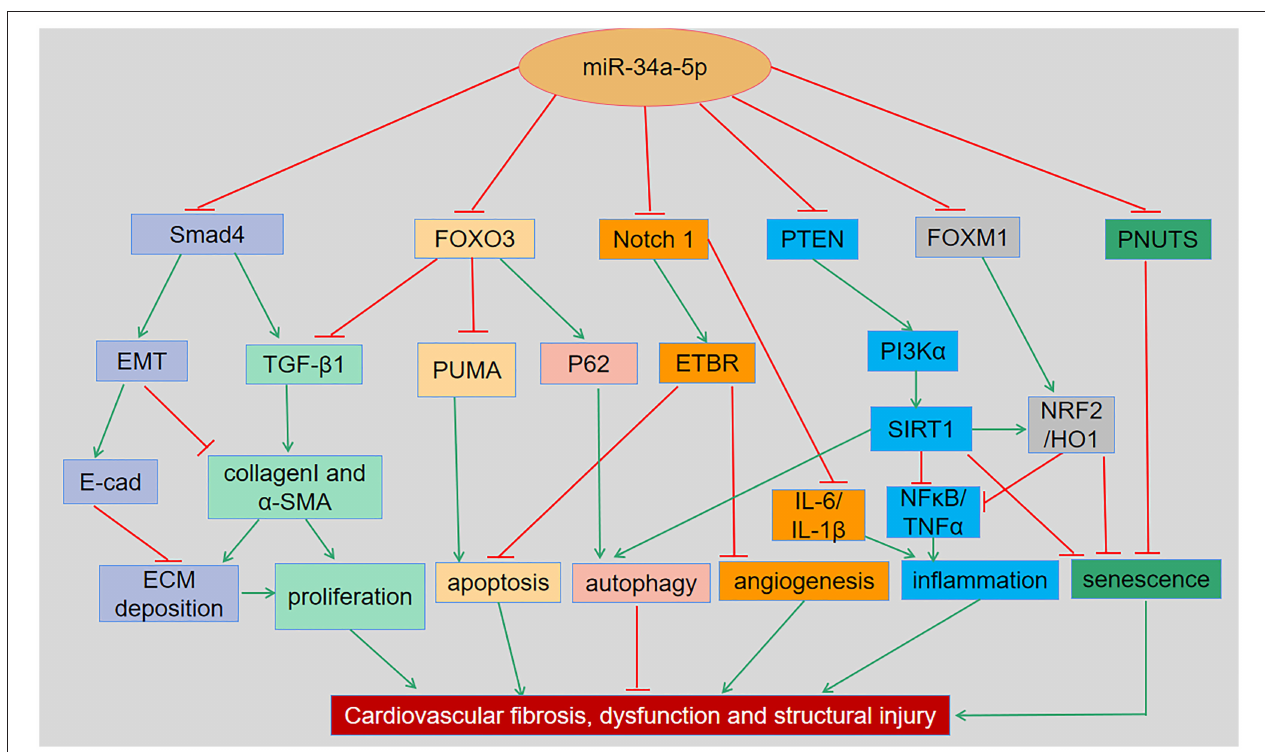
FIGURE 2 | The regulatory roles and underlying mechanisms of miR-34a in cardiovascular dysfunction and related disorders. MiR-34a has been shown to regulate cellular apoptosis, autophagy, inflammation, senescence and remodeling in various cardiac and vascular tissues and cells through Smad4/TGF- β 1, FOXO3/PUMA, Notch1/ETBR, PTEN/PI3K/SIRT1, and FOXM1/NRF2/HO-1 signaling pathways, respectively. EMT, Epithelial-mesenchymal transition; ECM, Extracellular matrix; ETBR, endothelial receptor type B; FOXM1, Forkhead box M1; FOXO3, Forkhead box O3; NRF2, Nuclear factor-E2-related factor 2; PI3K, Phosphatidylinositol 3-kinase; PNUTS, Phosphatase-1 nuclear targeting subunit; PTEN, Phosphatase and tensin homologue; PUMA, p53-up-regulated modulator of apoptosis; SIRT1, Silent information regulator 1; TGF- β 1, Transforming growth factor β